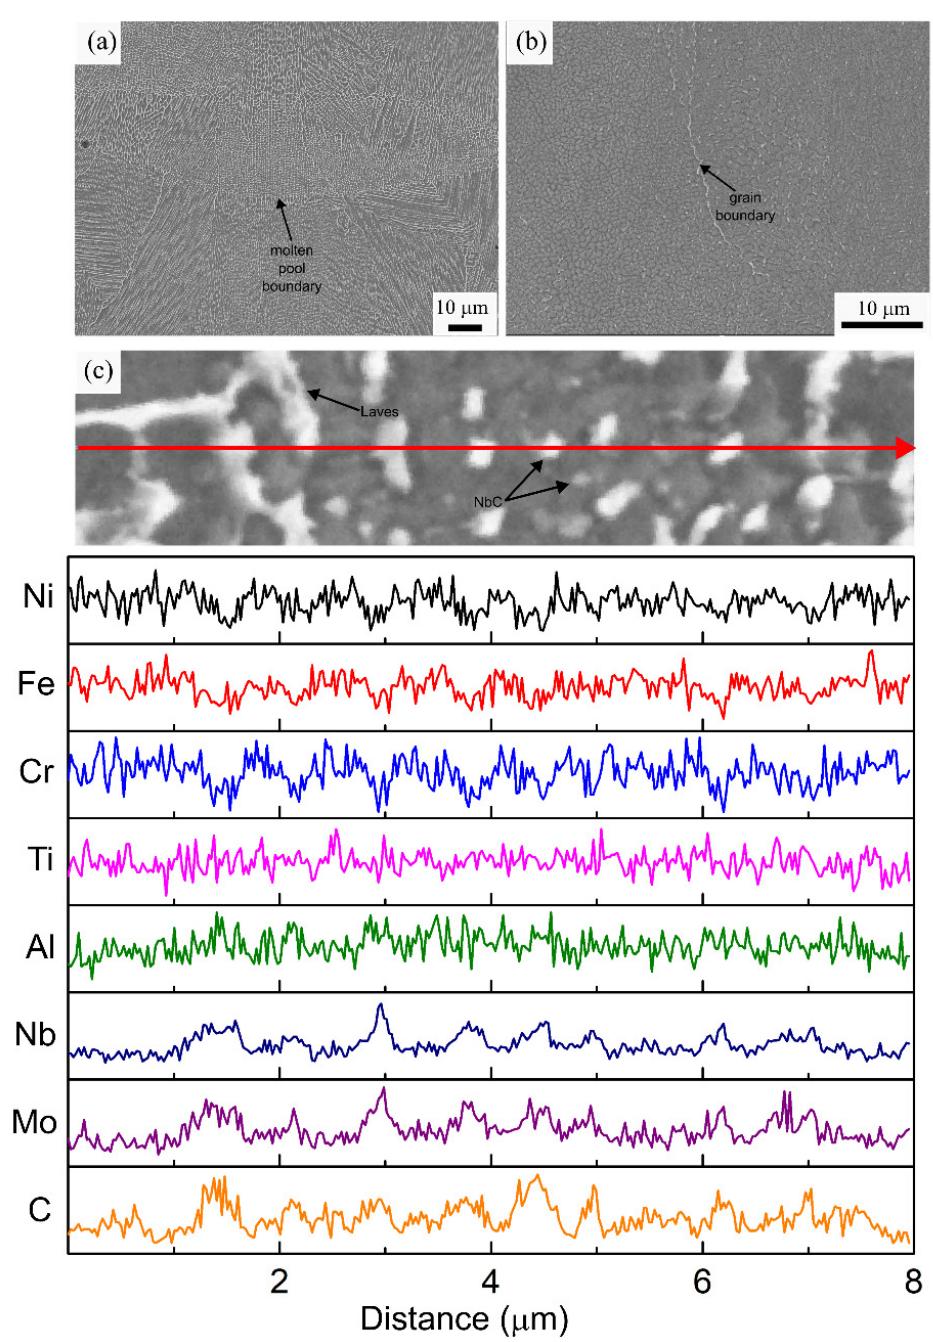
Figure 7. ( a , b ) Representative SEM micrographs, ( c ) EDS line scan analysis of the AB specimen along the marked red arrow.